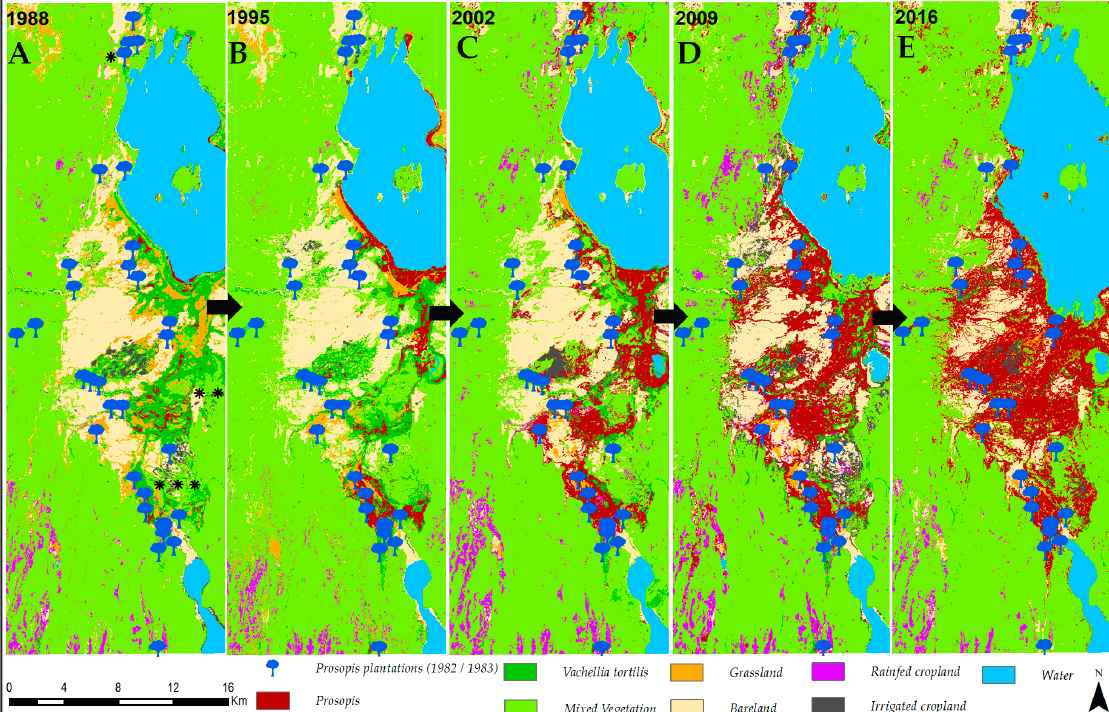
Figure 6. Invasion pattern of Prosopis from original plantations of 1982 and 1983. The blue trees represent the plantations, and the Prosopis invaded areas are shown in deep red. The sequence of LULC maps showing a zoom view south of Lake Baringo illustrates the gradual increase in Prosopis spatial coverage and a general decline in most of the other LULC, particularly grassland and V. tortilis over time ( A – E ). Locations Loruk*, Logumgum**, and Sandai*** are indicated with a symbol in the 1988 map.